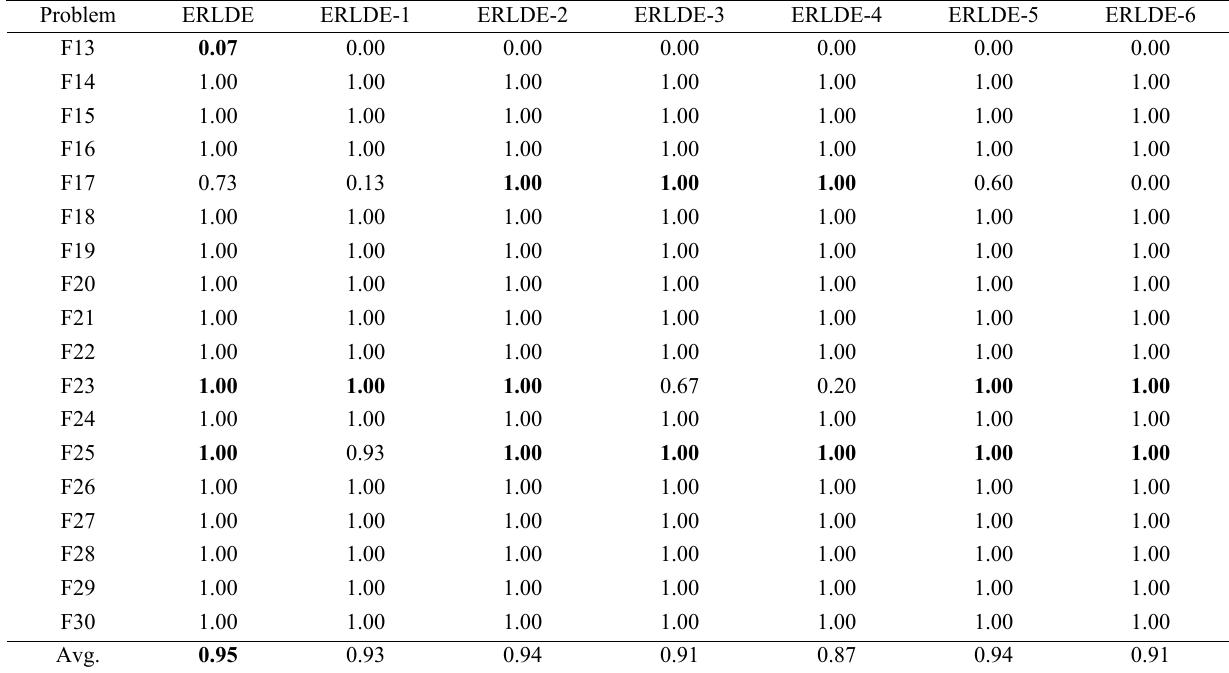
Table A5 Comparison between ERLDE and other ERLDE variants with respect to SR .